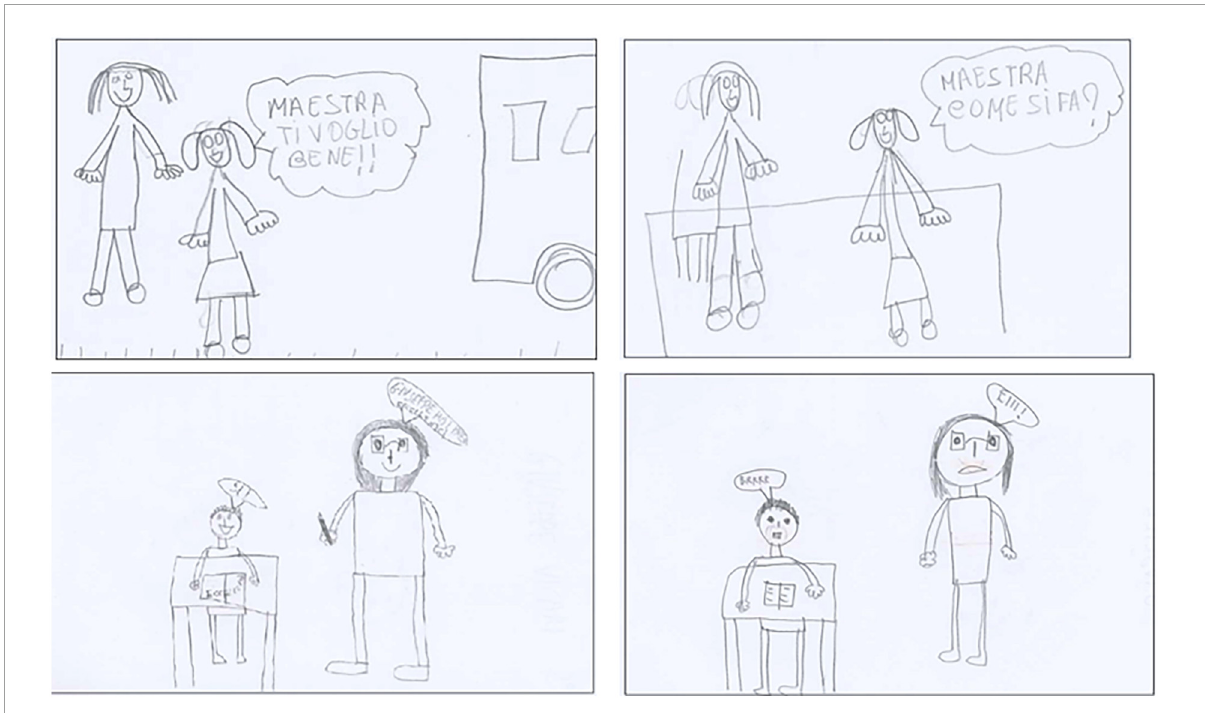
FIGURE1 Examples of different valorization of the teacher by gender, independently from the situation. Drawings in the upper section are by the same girl; those in the bottom section are by the same boy; both children are in 2nd grade. Wellbeing drawings are at the left. (Upper drawing): Child “Teacher, I love you”. (Lower drawing): Teacher “Giuseppe, your work was excellent”; Child “Yes!” Distress drawings are at the right. (Upper drawing): Child “Teacher, how should I do it?” (Lower drawing): Teacher “Hey!”; Child